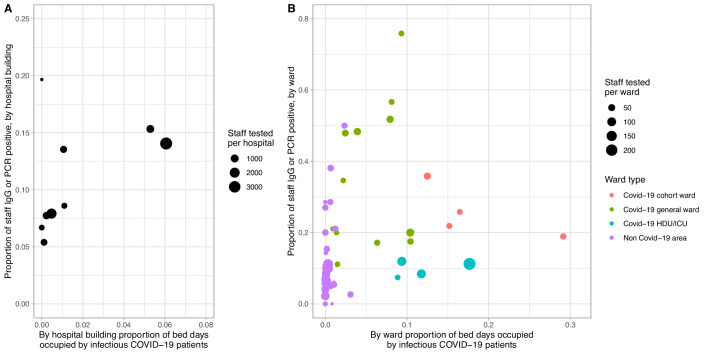
Proportion of staff infected by extent of Covid-19 infectious pressure from patients, by eight hospital buildings across four hospitals (panel A) and by ward (panel B).Covid-19 infectious pressure was calculated by considering each patient infectious from −2 to +7 days around the date of their first positive SARS-CoV-2 PCR test. Only staff working in a single hospital or ward are included in the plot. Wards with fewer than 10 staff tested are not plotted. Covid-19 cohort wards admitted only patients with suspected or known Covid-19, whereas Covid-19 general wards were acute medical wards receiving new admissions and acute medical patients initially believed not to have Covid-19. Non Covid-19 areas did not admit suspected Covid-19 patients and any suspected or confirmed Covid-19 patients were transferred off these wards as soon as possible.